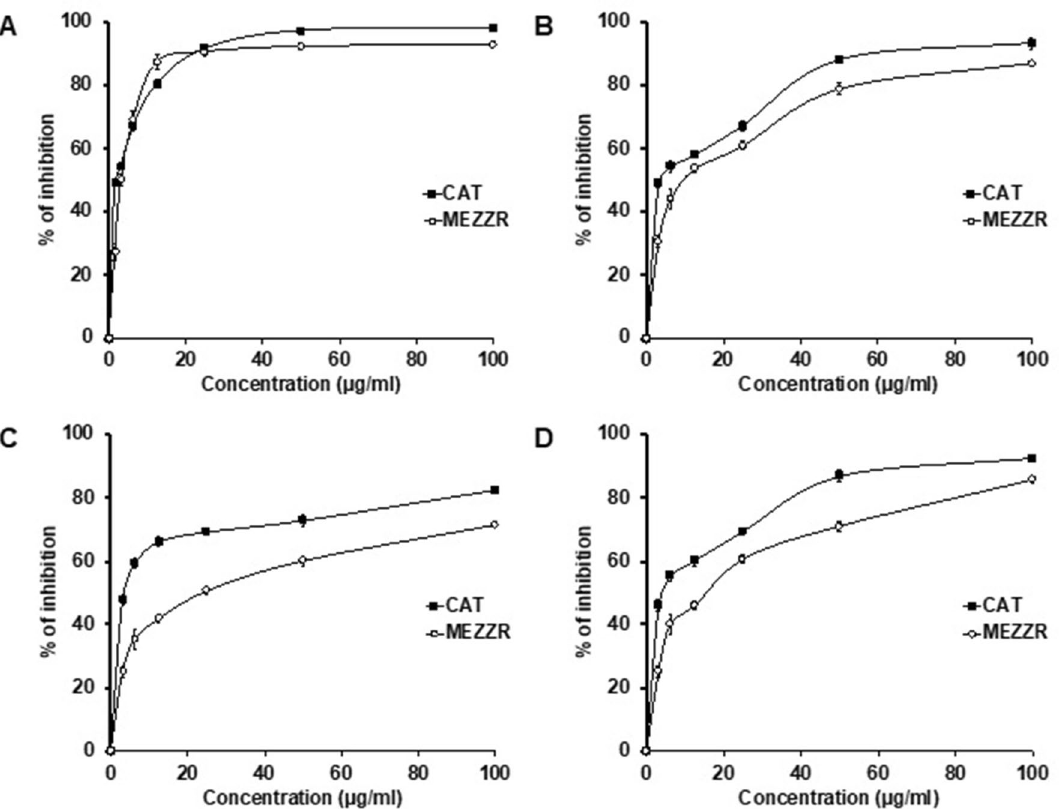
Figure 2. Determination of ( A ) DPPH radical scavenging activity, ( B ) ABTS radical scavenging activity, ( C ) Nitric oxide radical scavenging activity, and ( D ) lipid peroxidation inhibition activity of MEZZR and catechin. Data represents the mean ± SD from three